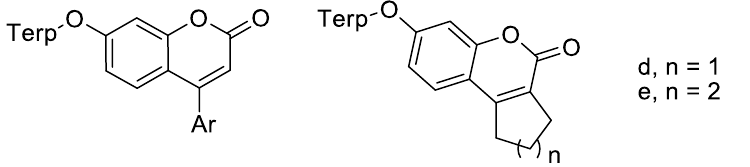
Figure 1. Structures of 7 - terpenylcoumarins with antiviral and Tdp1-inhibiting activity.